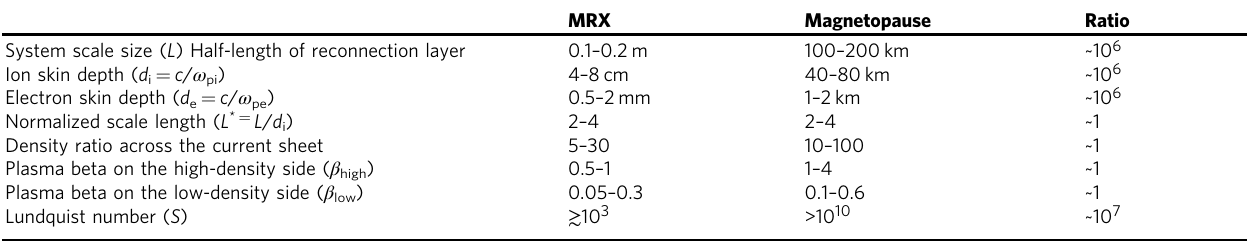
Table 1 Plasma parameters and scale sizes of MRX and at the magnetopause